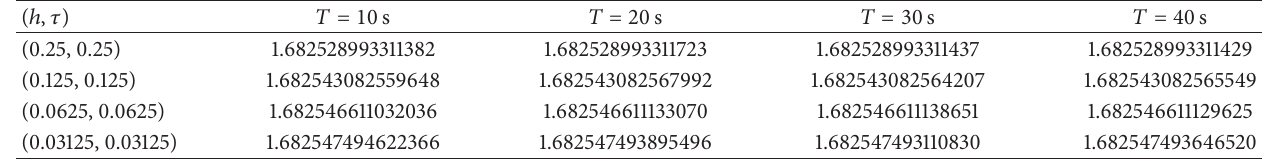
Table 3: The energy of different time in different time step and space step for 𝑝 = 3 .